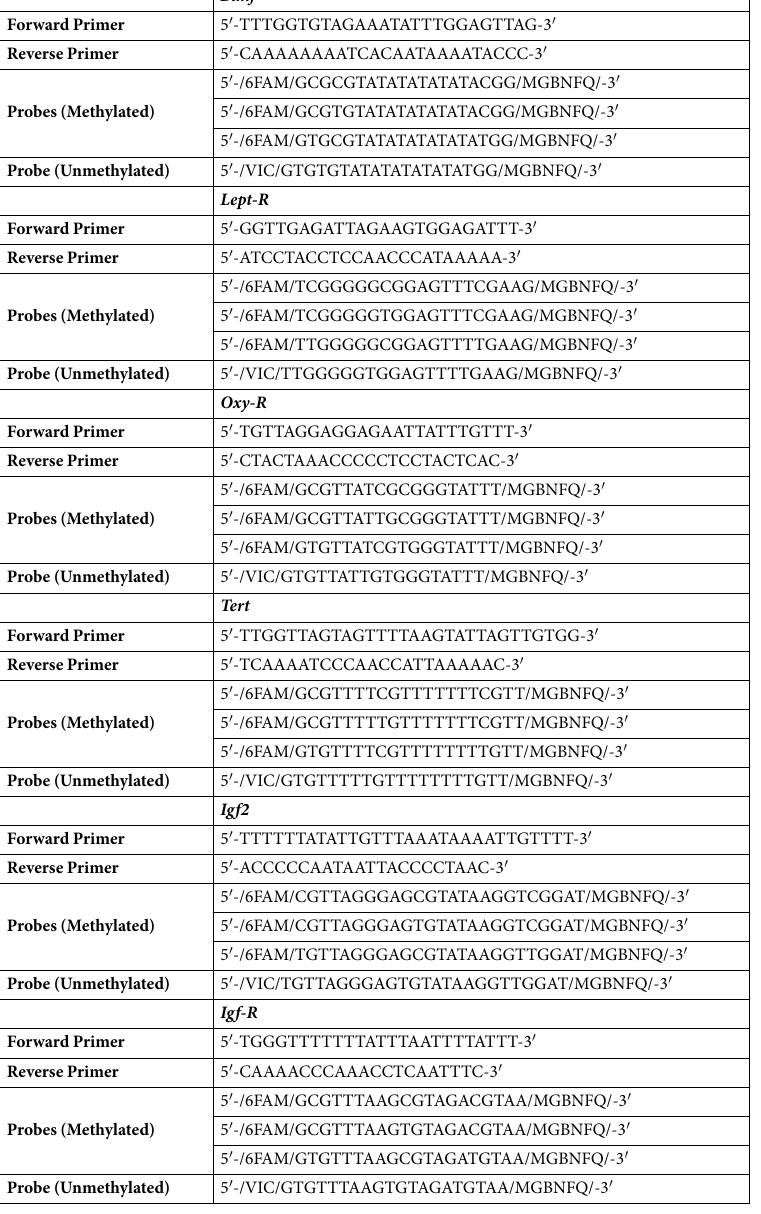
Table 6. Methylight RT-qPCR primers and methylation-specific